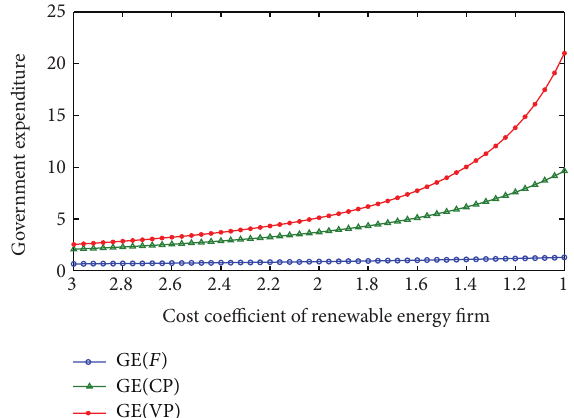
Figure 7: Three tools comparison on government expenditure under the change of cost coefficient of renewable energy firm 𝑐 𝑅 .